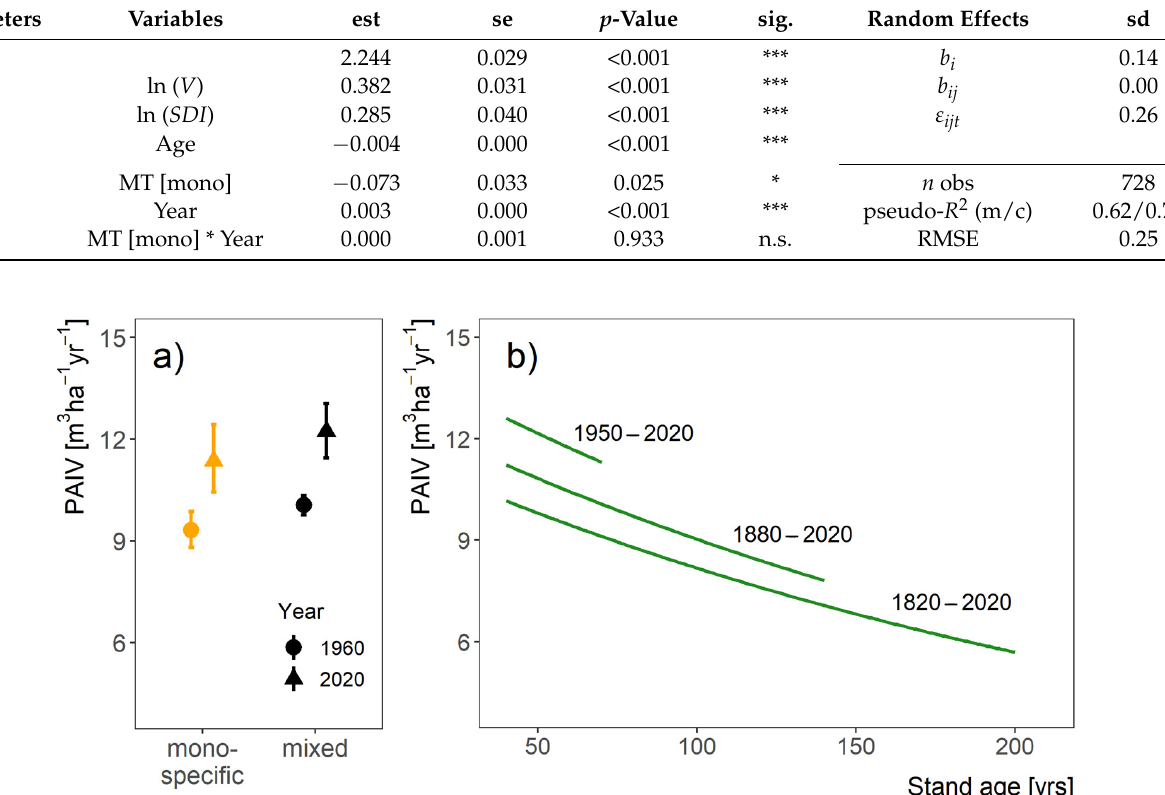
Figure 1. Stand productivity for monospecific and mixed oak stands at the age of 100 for different Calendar years ( a ); stand productivity for monospecific oak stands as a function of stand age after culmination (not shown) for different growing periods ( b ); all other variables were set to their mean.